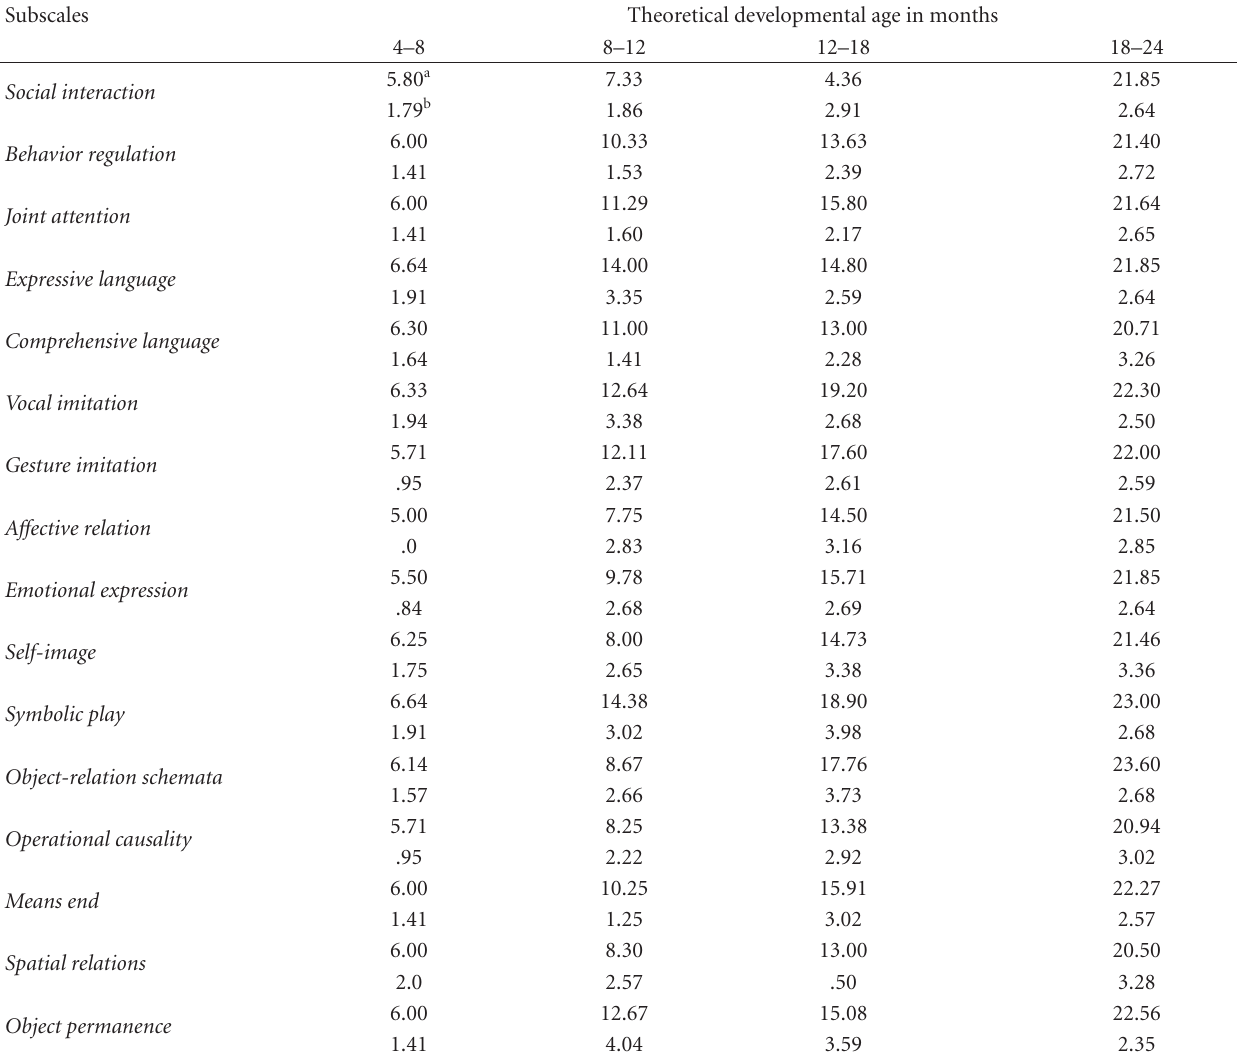
Table 5: Agreement between theoretical and observed